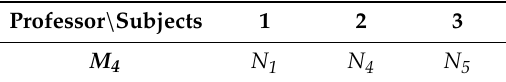
Table 3. Selected subjects for Professor M 4